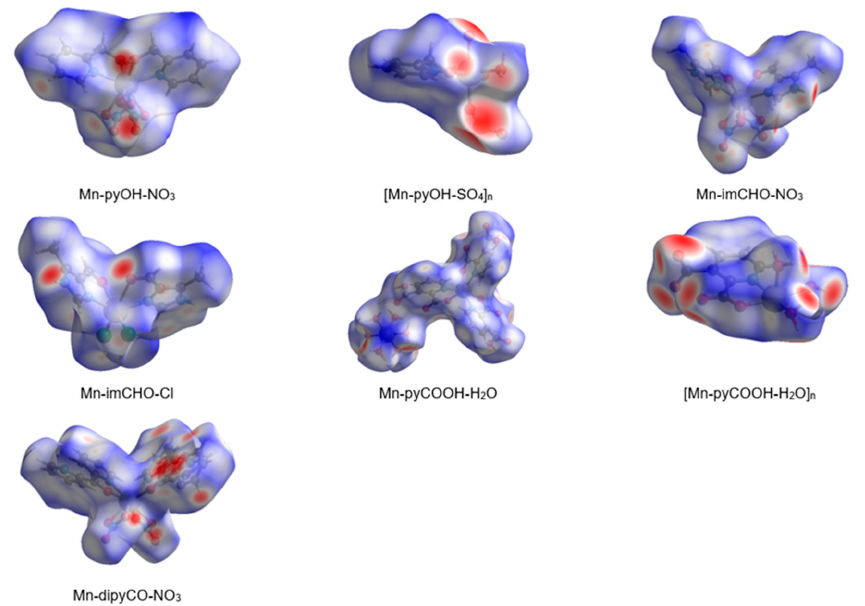
Figure 4. The Hirshfeld surfaces of series of the Mn(II) complexes mapped with 3D d norm (with transparency enabled). transparency (Figure S2). Main reciprocal intermolecular interactions (O ⋯ H, H ⋯ H, C ⋯ H) were ob-